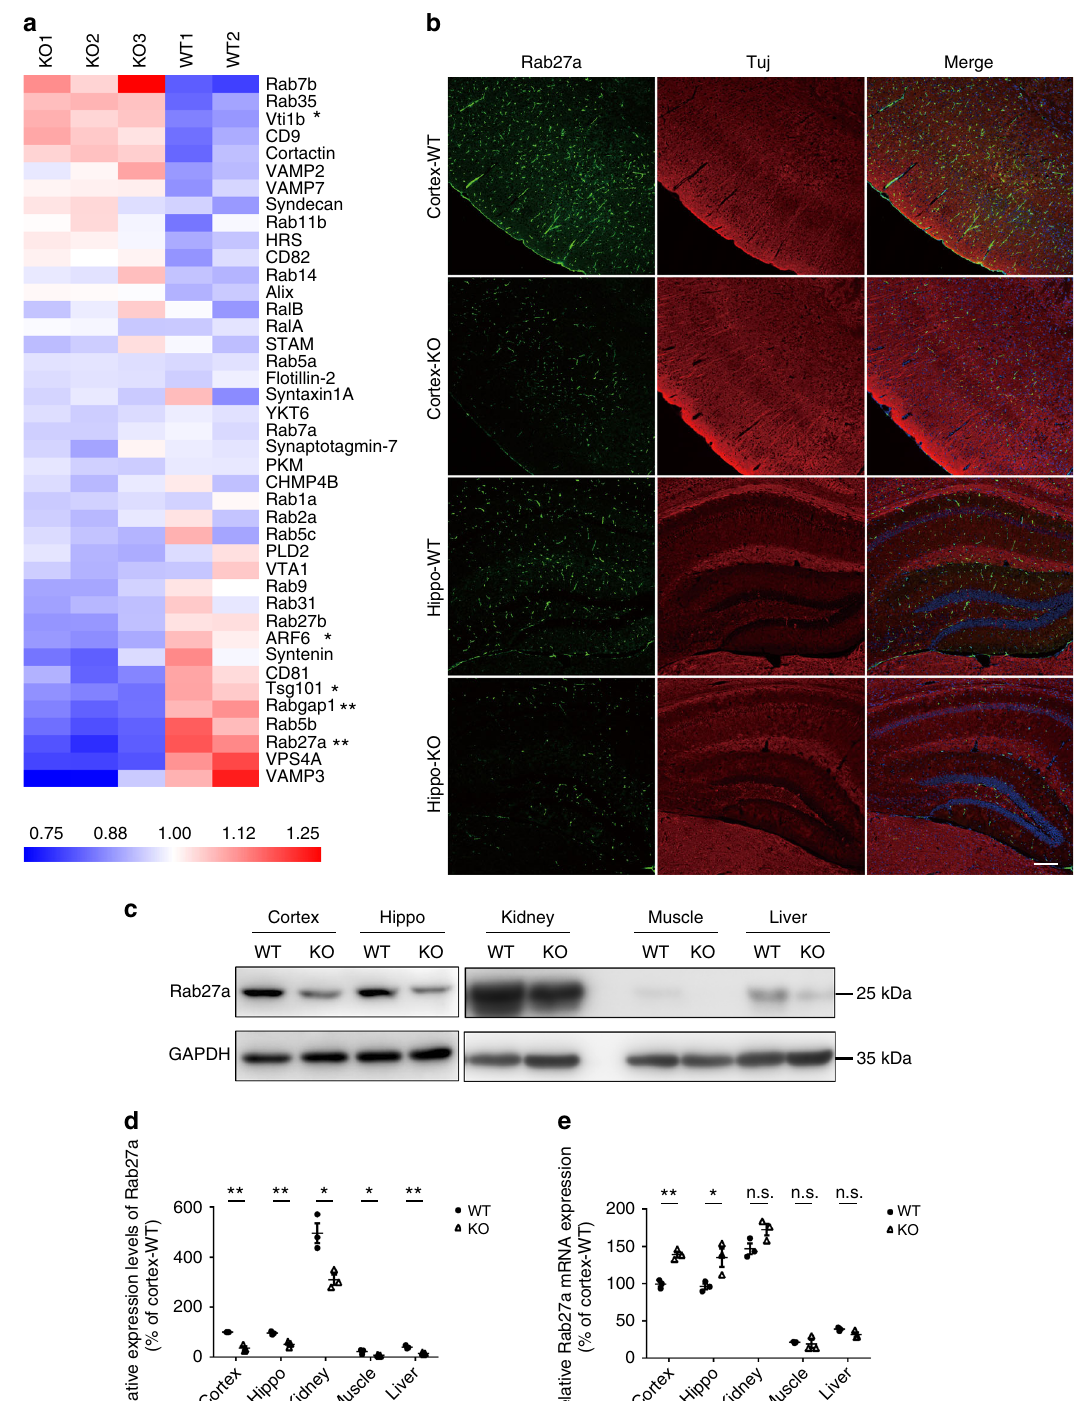
Fig. 4 Depleting KIBRA promotes the degradation of Rab27a. a Heat map of proteins involved in exosome biogenesis or secretion by mass spectrometry in the cortex and hippocampus of three KIBRA-KO mice and two wild-type (WT) controls. Proteins are arranged according to fold change values. Upregulated and downregulated proteins are indicated by red and blue hues, respectively. Color intensity indicates the expression levels of proteins as displayed. b Rab27a was detected by immuno fl uorescent staining in the cortex and hippocampus of KIBRA-KO mice and WT controls ( n = 3 in each group). Scale bar = 200 μ m. c Western blot was performed to determine the Rab27a protein levels in the cortex, hippocampus, kidney, muscle, and liver of KIBRA-KO mice and WT controls ( n = 3 in each group). d Quanti fi cation of Rab27a levels in different tissues of KIBRA-KO and WT mice in three independent experiments. e Real-time PCR was performed to determine the mRNA levels in different tissues of KIBRA-KO and WT mice ( n = 3 in each group). The quanti fi cation results were plotted as dot plots, showing the mean± SE. * P < 0.05, ** P < 0.01. n.s., not signi fi cant ( P > 0.05) as determined by two-tailed t